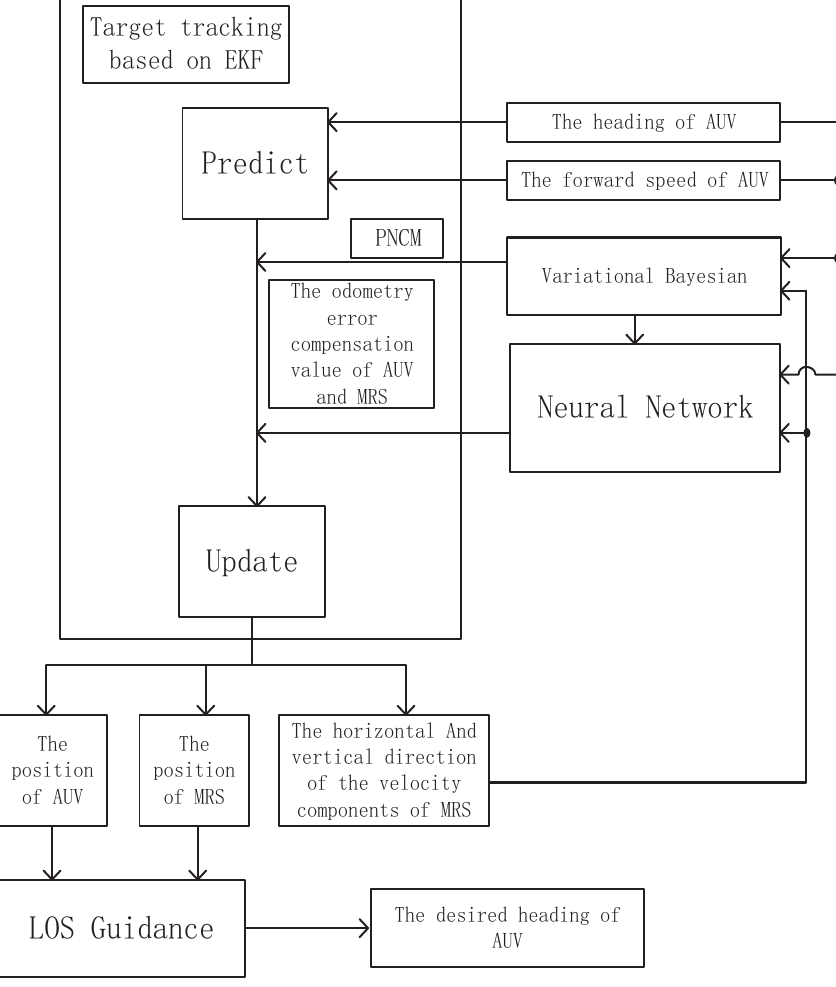
Figure 2. The overview of our